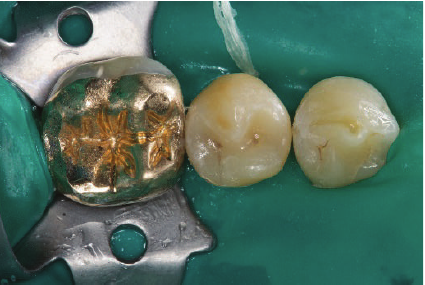
Figure12:Adhesivecementationoftherestorationafterrubberdam